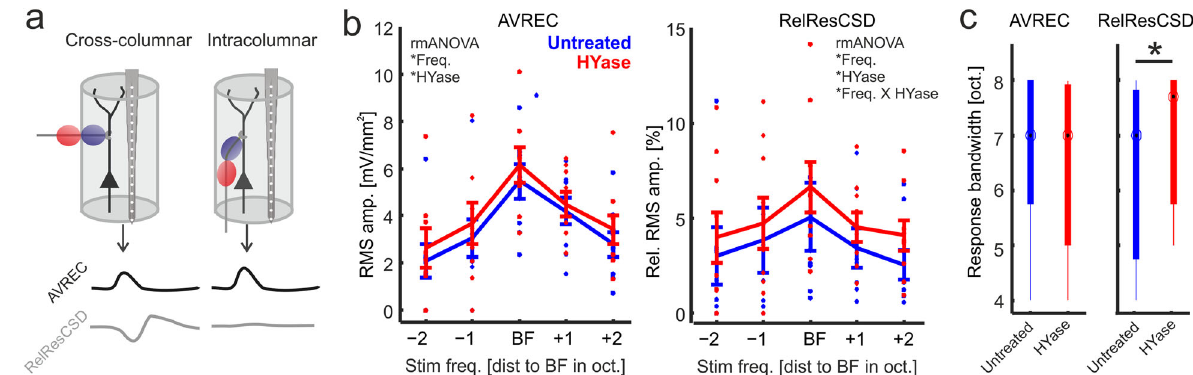
Fig. 3 Quanti fi cation of AVREC and RelResCSD frequency tuning after ECM removal. a Schema illustrating how the averaged recti fi ed CSD amplitude (black) and the relative residuals of sinks and sources of the extracellular electric fi eld (gray) are reconstructed from linear recording arrays along the depth of the cortical space. Synaptic activity measured within the indicated integration cylinder of the electrode is mainly associated with local columnar activity (AVREC), while the RelResCSD quanti fi es contributions from lateral corticocortical input. b Frequency-response tuning curves of AVREC RMS amplitudes (±SEM) showed increased activity across all stimulation frequencies. RelResCSD showed increase that was depending on stimulation frequency ( n = 9; represent by individual data points for each animal). Signi fi cant main effects and interactions of a 2-way-rmANOVA are indicated in each subpanel by the asterisk * (for results see Table 1). c Correspondingly, AVREC showed no change of Q40dB bandwidth (Student ’ s t-test, p > 0.05), while RelResCSD bandwidths were signi fi cantly increased (*paired Student ’ s t-test, p = 0.02). Box plots represent the median (circle) and the interquartile range (25% and 75% percentile). The whiskers represent the full range of data.